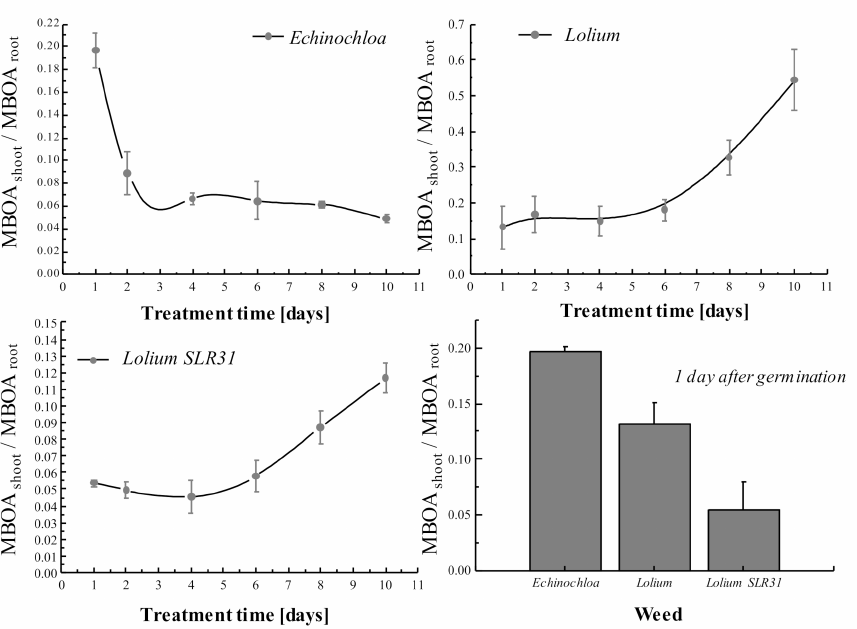
Figure 4. Relationships for the [MBOA]shoot/[MBOA]root ratio for different treatment times with 3 mM MBOA and comparative levels for one day after germination (Bar Graph). Error bars represent standard deviation for n =